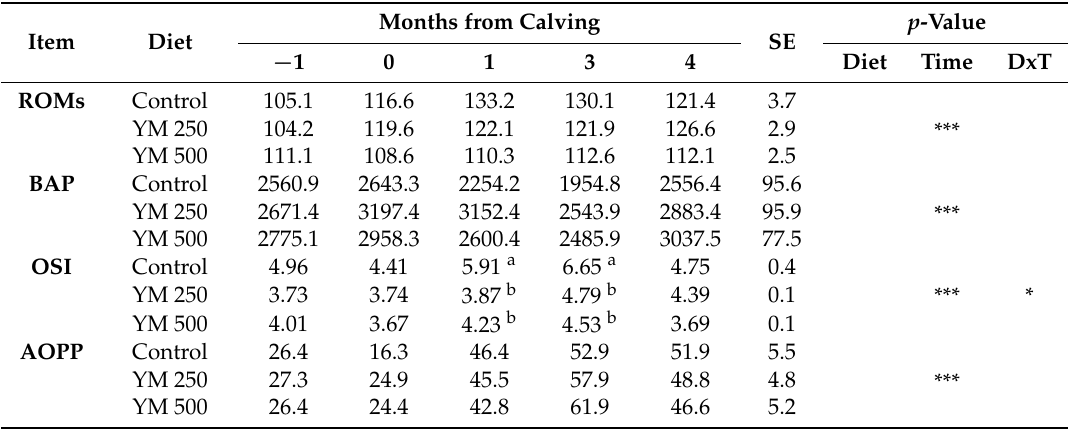
Table 1. The effect of Yerba Mate (YM) supplementation on redox balance in dairy